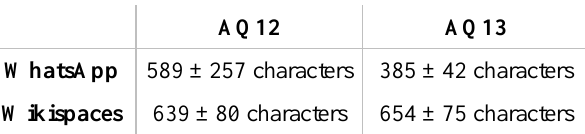
TABLE I. Number of characters in the texts produced in the